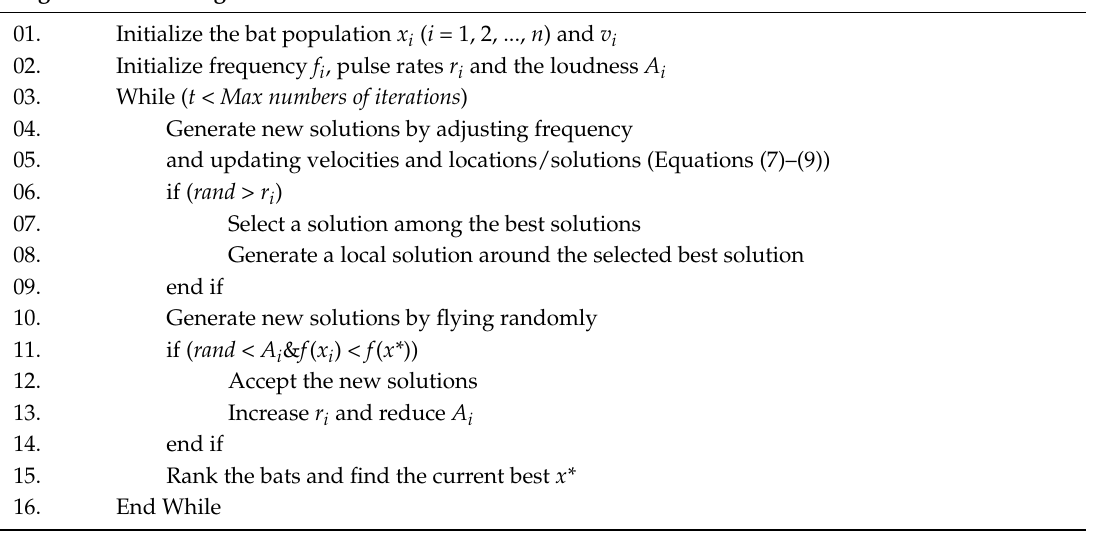
Algorithm 5. Bat Algorithm.